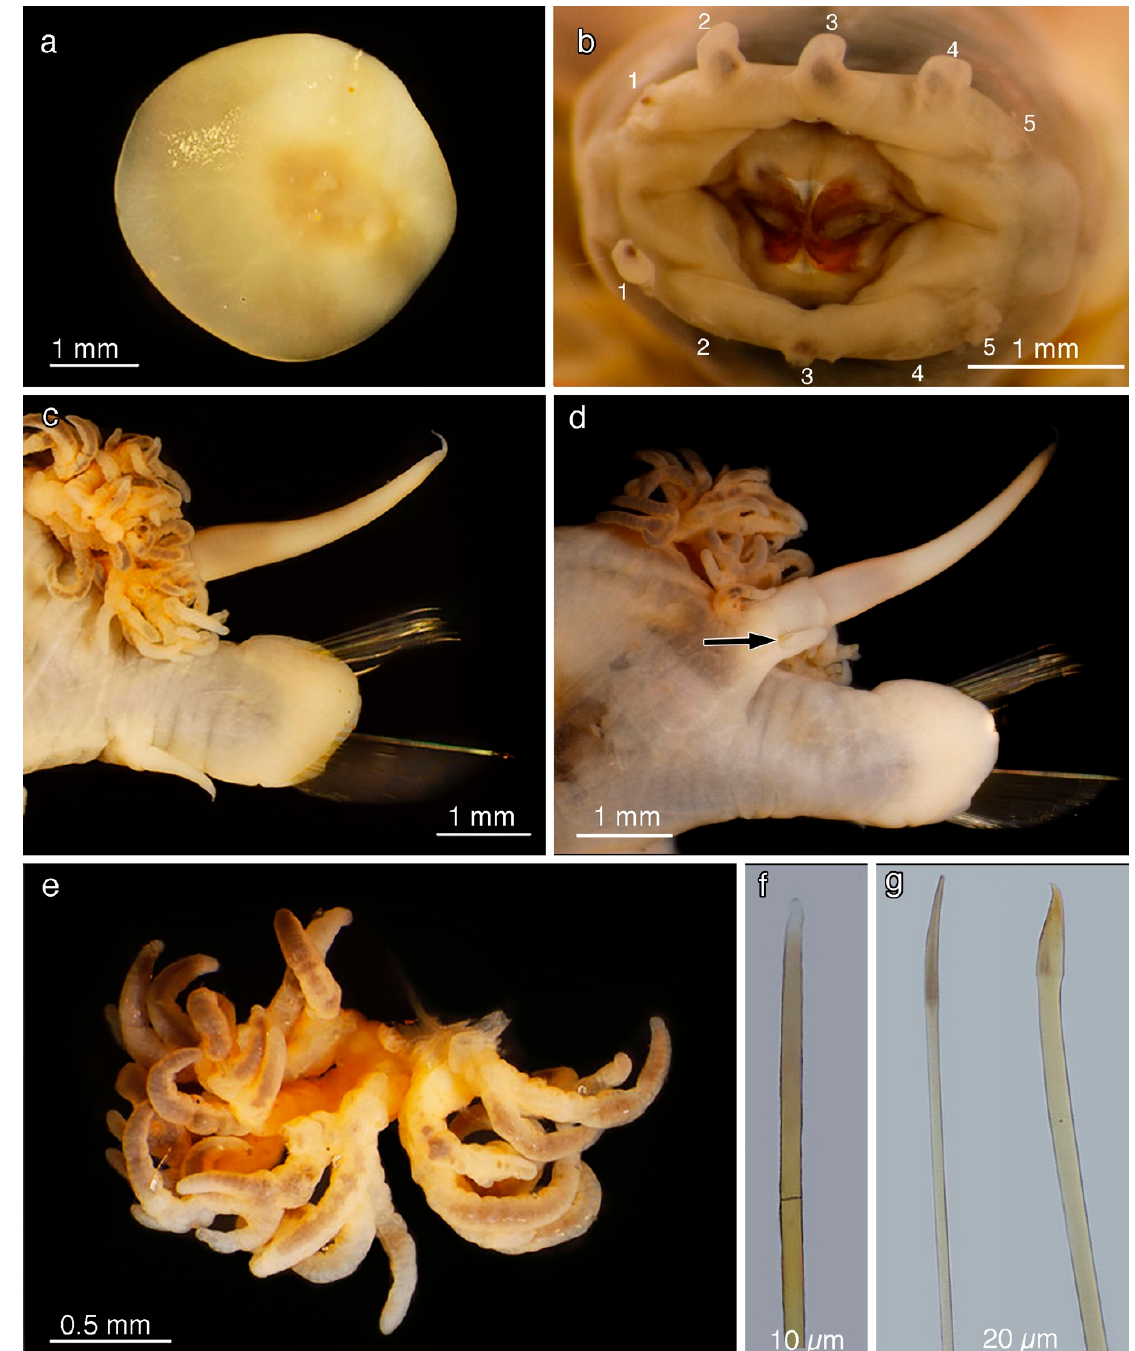
Figure 19. Branchipolynoe tjiasmantoi n. sp. preserved female holotype (SIO-BIC A5460). ( a ) Elytron from Segment 5. ( b ) Frontal view of proboscis showing papillae and jaws of holotype. ( c ) Parapodium from Segment 12 with dorsal cirrus, rostral view. ( d ) Parapodium from Segment 12 with dorsal cirrus, caudal view; arrow indicates notopodium. ( e ) Branchia from Segment 10. ( f ) Notochaeta (Segment 12). ( g ) Supraacicular neurochaeta (left) and subacicular neurochaeta (right) (Segment 12) .